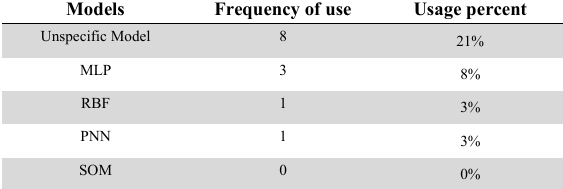
Comparison of the Artificial Neural Network models